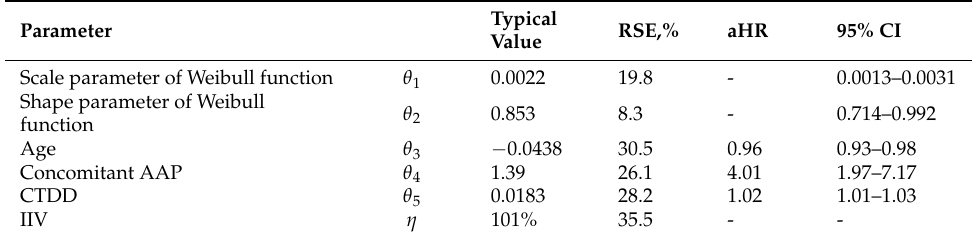
Table 5. Estimated parameters of the repeated time-to-event final model for improving positive symptoms following clozapine treatment (n = 116).